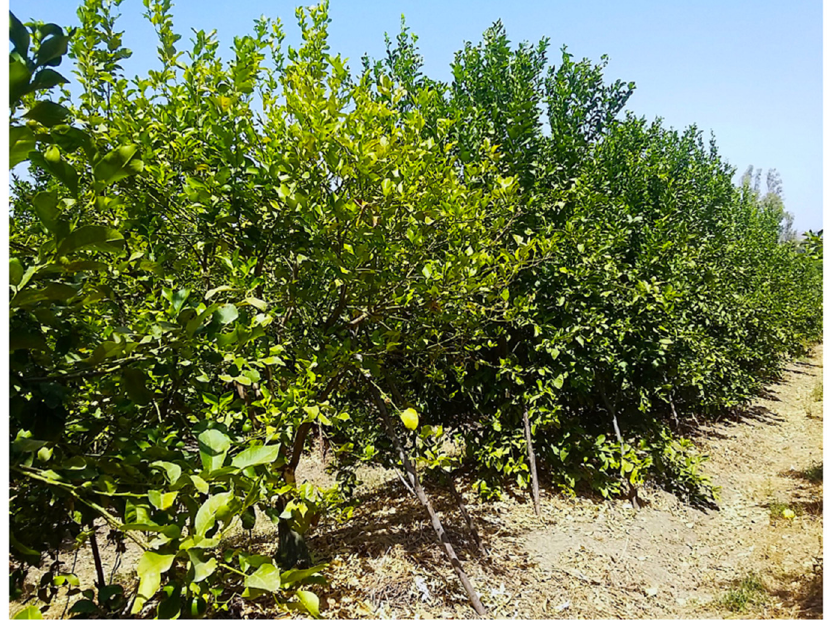
Figure 4. In the foreground, a lemon tree approximately 20-yr-old with yellowing of the canopy as a consequence of bot gummosis on scaffold branches.